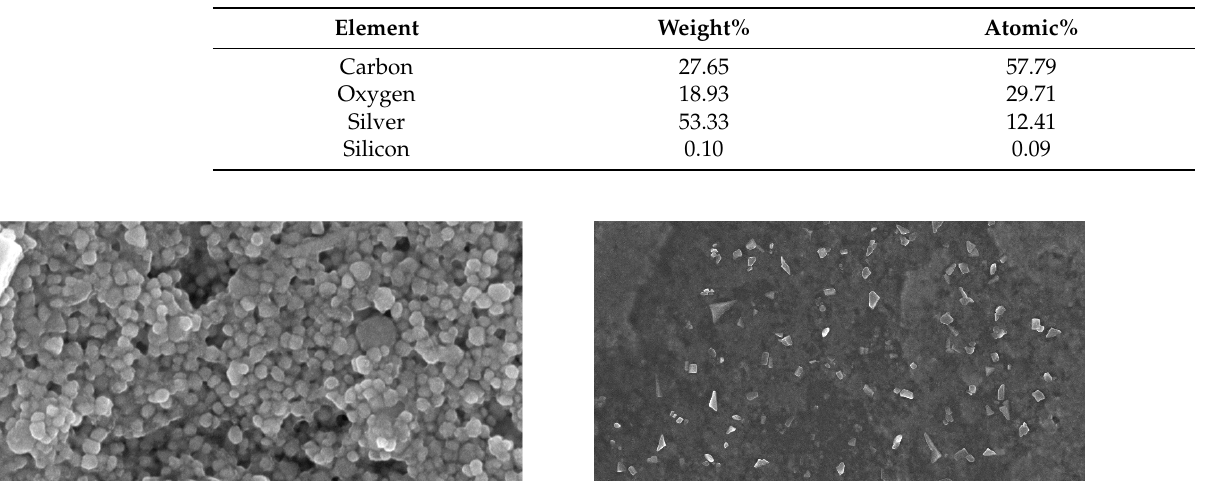
Table 1. EDX analysis parameters of AgNPs.